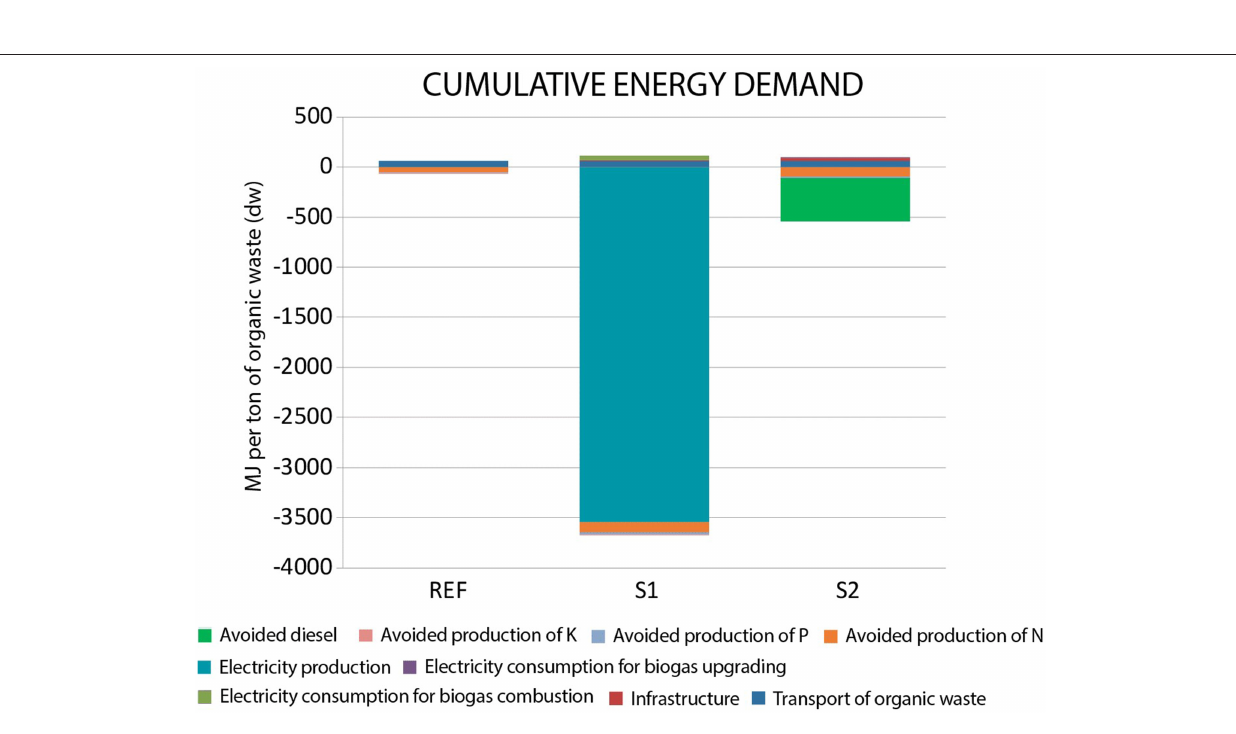
Frontiers in Energy Research |